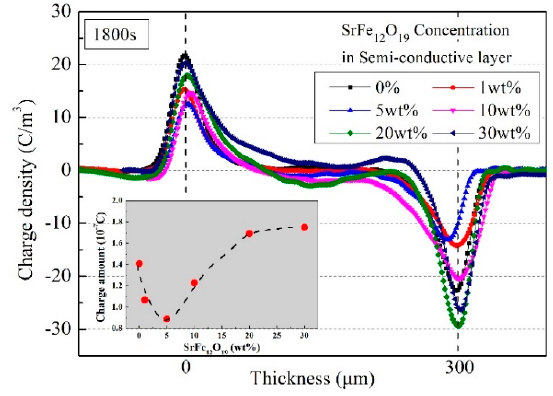
Figure 7. Comparison of space charge distributions at 1800 s in in insulation sample under semi-conductive composites with different SrFe 12 O 19 contents.